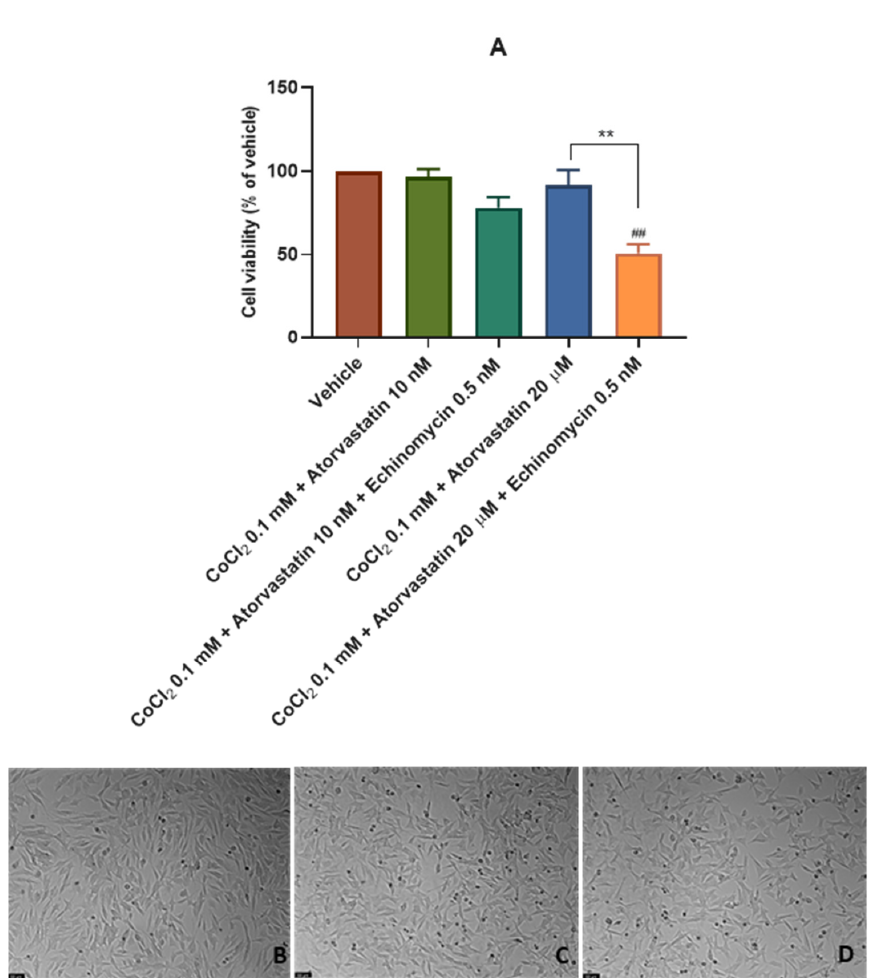
Figure 6. Effect of ( A ) CoCl 2 0.1 mM + atorvastatin 10 nM , CoCl 2 0.1 mM + atorvastatin 20 µ M, CoCl 2 0.1 mM + atorvastatin 10 nM + echinomycin 0.5 nM, and CoCl 2 0.1 mM + atorvastatin 20 µ M +